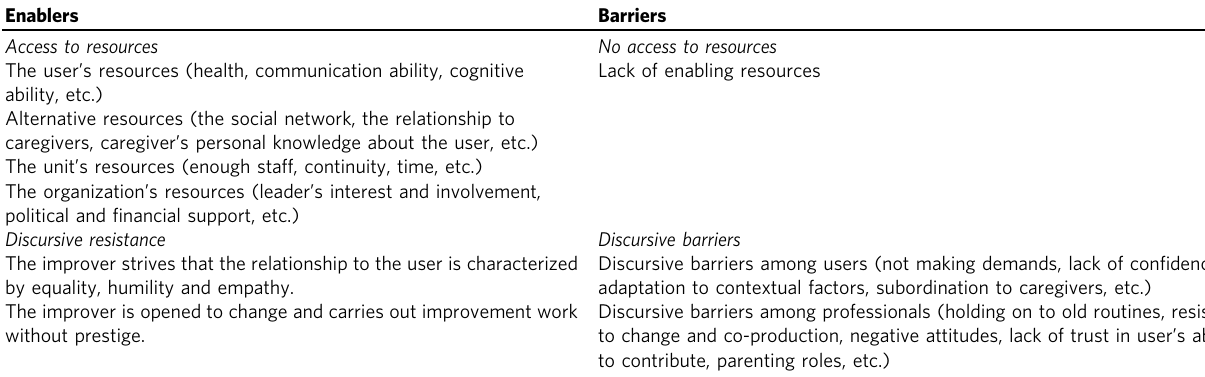
Table 1 The two categories and four subcategories from the data analysis in fi rst part of the study.